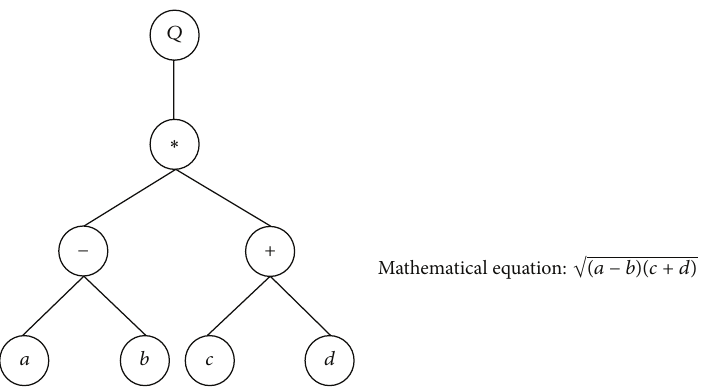
Figure 1: Example of GEP expression tree and mathematical